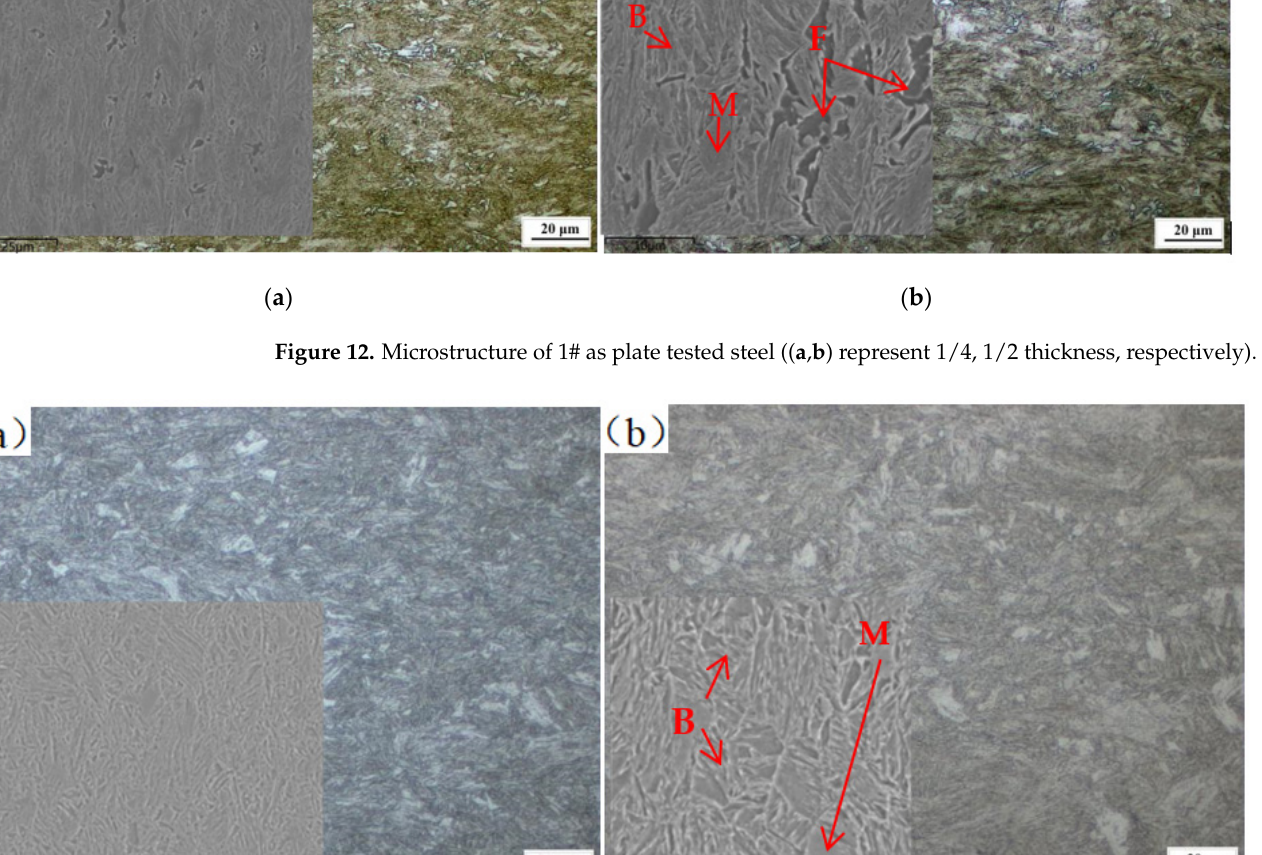
Figure 13. Microstructure of 2# as plate tested steel (( a , b ) represent 1/4, 1/2 thickness, respectively).